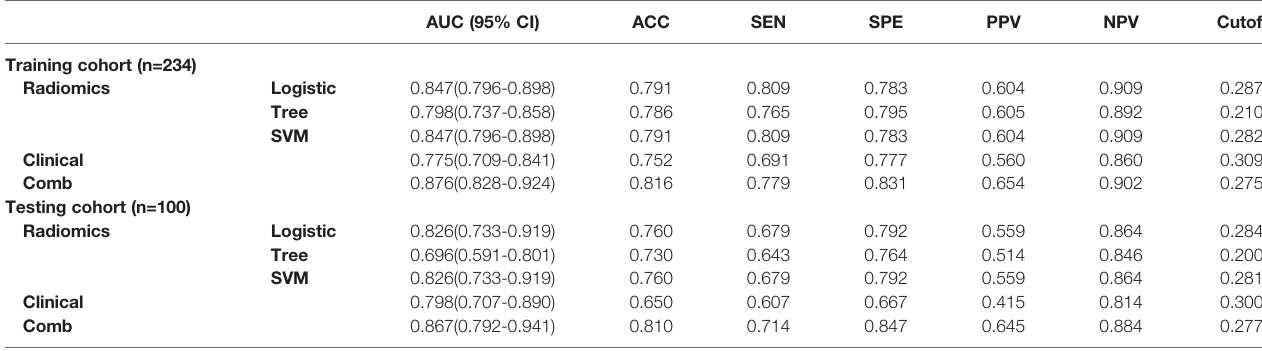
TABLE 3 | Diagnostic performance of individualized prediction models.